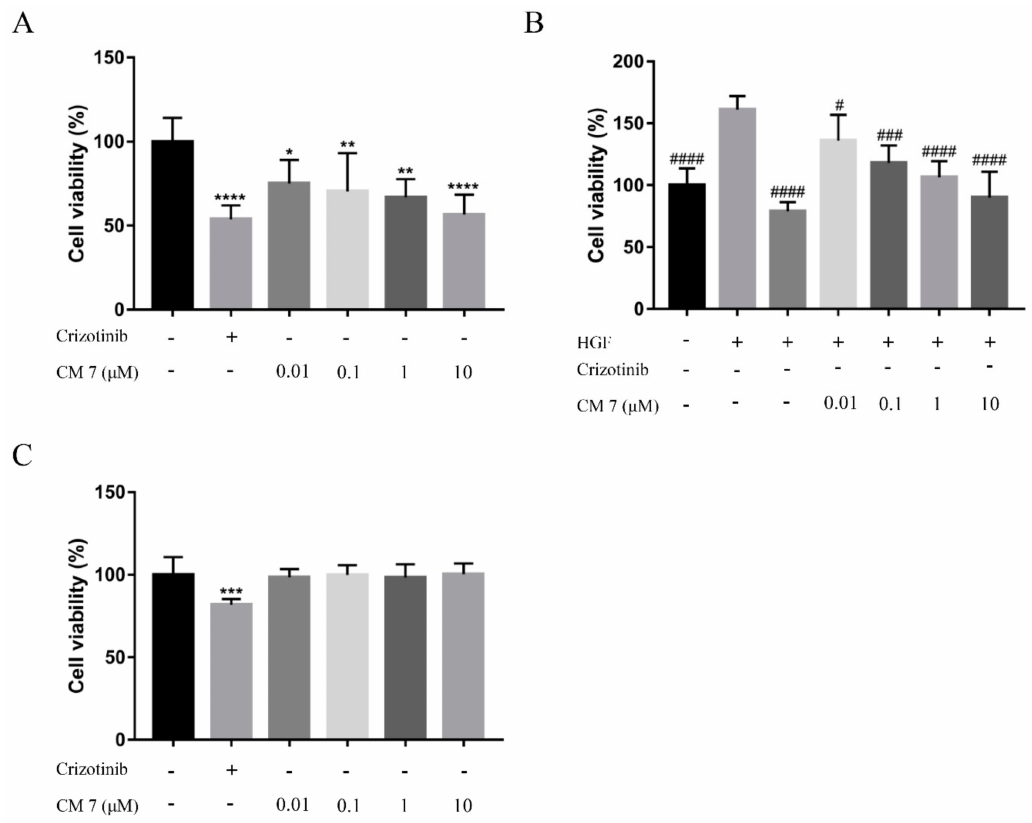
Figure 5. Cell proliferation assay: Inhibition of MKN-45, MKN-28, and U87 cell proliferation by the peptide CM 7. ( A ) MKN-45 cells were treated with various concentrations of CM 7, and cell viability was calculated after four days. ( B ) U87 cell proliferation was stimulated by 20 ng / mL HGF, cells were treated with various concentrations of CM 7, and cell viability was calculated after four days. ( C ) MKN-28 cells were treated with various concentrations of CM 7, and cell viability was calculated after four days. * p < 0.05, ** p < 0.01, **** p < 0.0001, indicate significant inhibition of MKN-45 or MKN-28 cell proliferation by CM 7 vs control; # p < 0.05, ### p < 0.001, ##### p < 0.0001, indicate significant inhibition of U87 cell proliferation by CM 7 vs HGF. Values are means of six di ff erent determinations; mean ± SD, one-way ANOVA with multiple